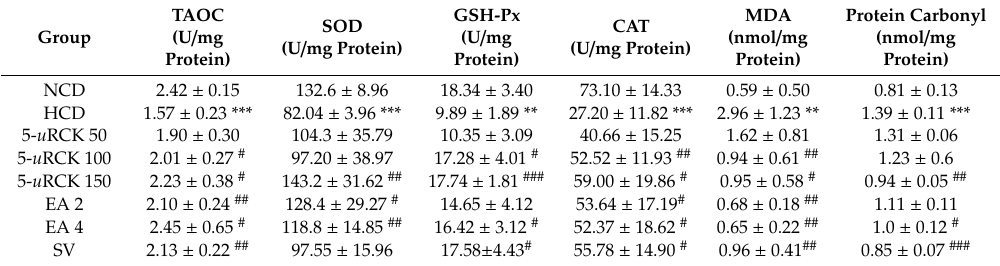
Table 6. E ff ect of 5- u RCK or ellagic acid on hepatic antioxidant enzyme activities in HCD-fed rats. ** p < 0.01, *** p < 0.001 versus the control (NCD) group. # p < 0.05, ## p < 0.01, ### p < 0.001 versus the HCD group. All data was shown as the mean ± SD ( n = 6–8). TAOC SOD Group (U / mg (U / mg Protein)